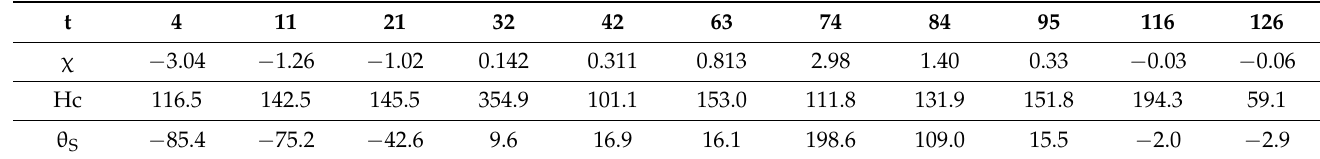
Table 2. The highest susceptivity ( χ , mdeg/Oe), the coercivity (Hc, Oe) and the saturated rotation angle ( θ S , mdeg) of the W/CoFeB (120 nm)/W thin films at different W thicknesses (t,